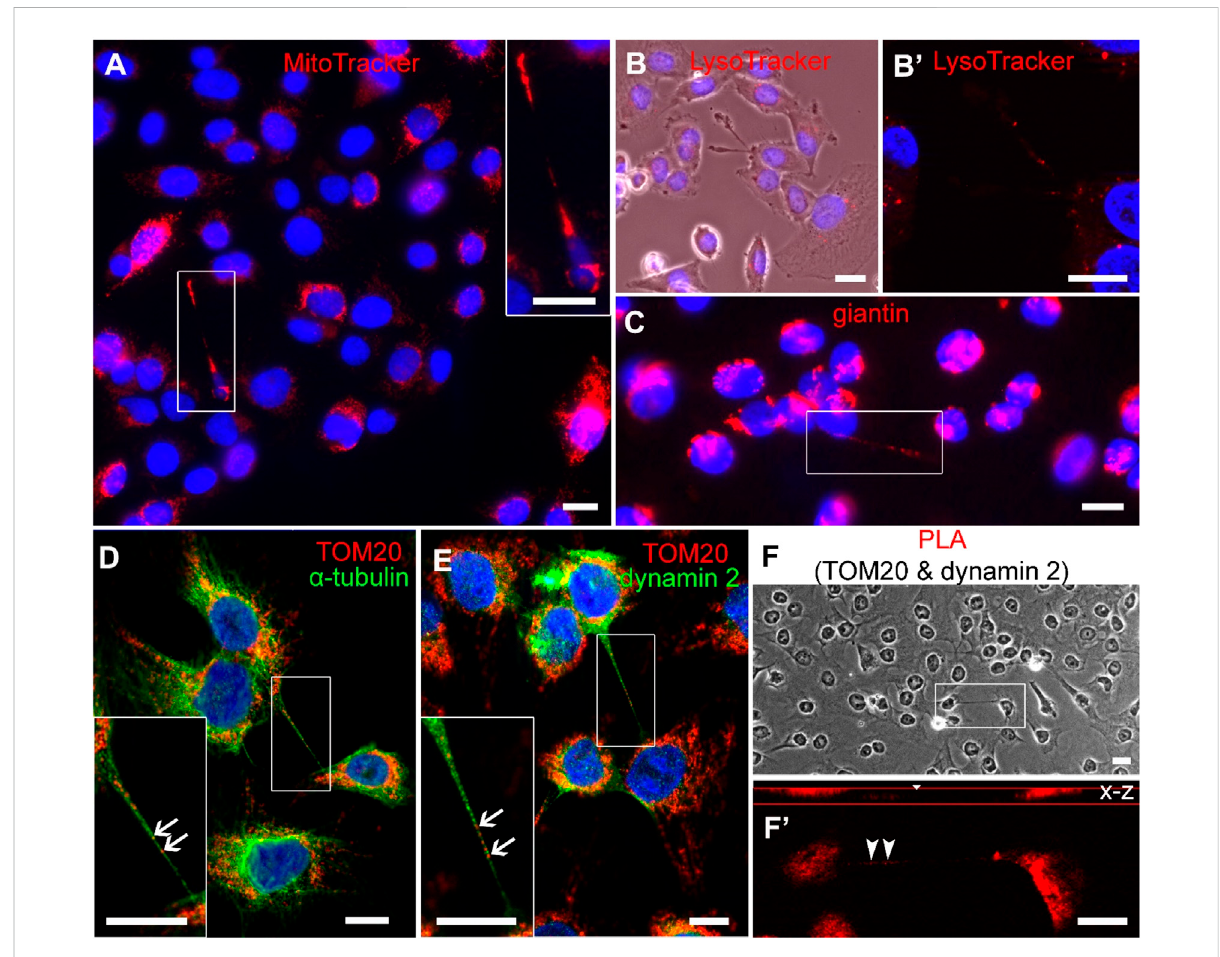
FIGURE 8 Colocalization of mitochondria and dynamin 2 in TNTs of cancer (T24) urothelial cells. Presence of (A) MitoTracker (B) LysoTracker (C) giantin and ( D-F ’ ) TOM 20 in TNTs (D) The distribution of TOM20 (arrows) and microtubules (green) in TNTs, and (E) TOM20 (arrows) and dynamin 2 (green) inTNTs. (F) Thecells were fi xedandsubjectedto proximityligationassay (PLA)usinganti-TOM20andanti-dynamin2antibodies. (F) TNTininset has positive PLA signal ( F ’ , arrowheads). Scale bars: 10 μ